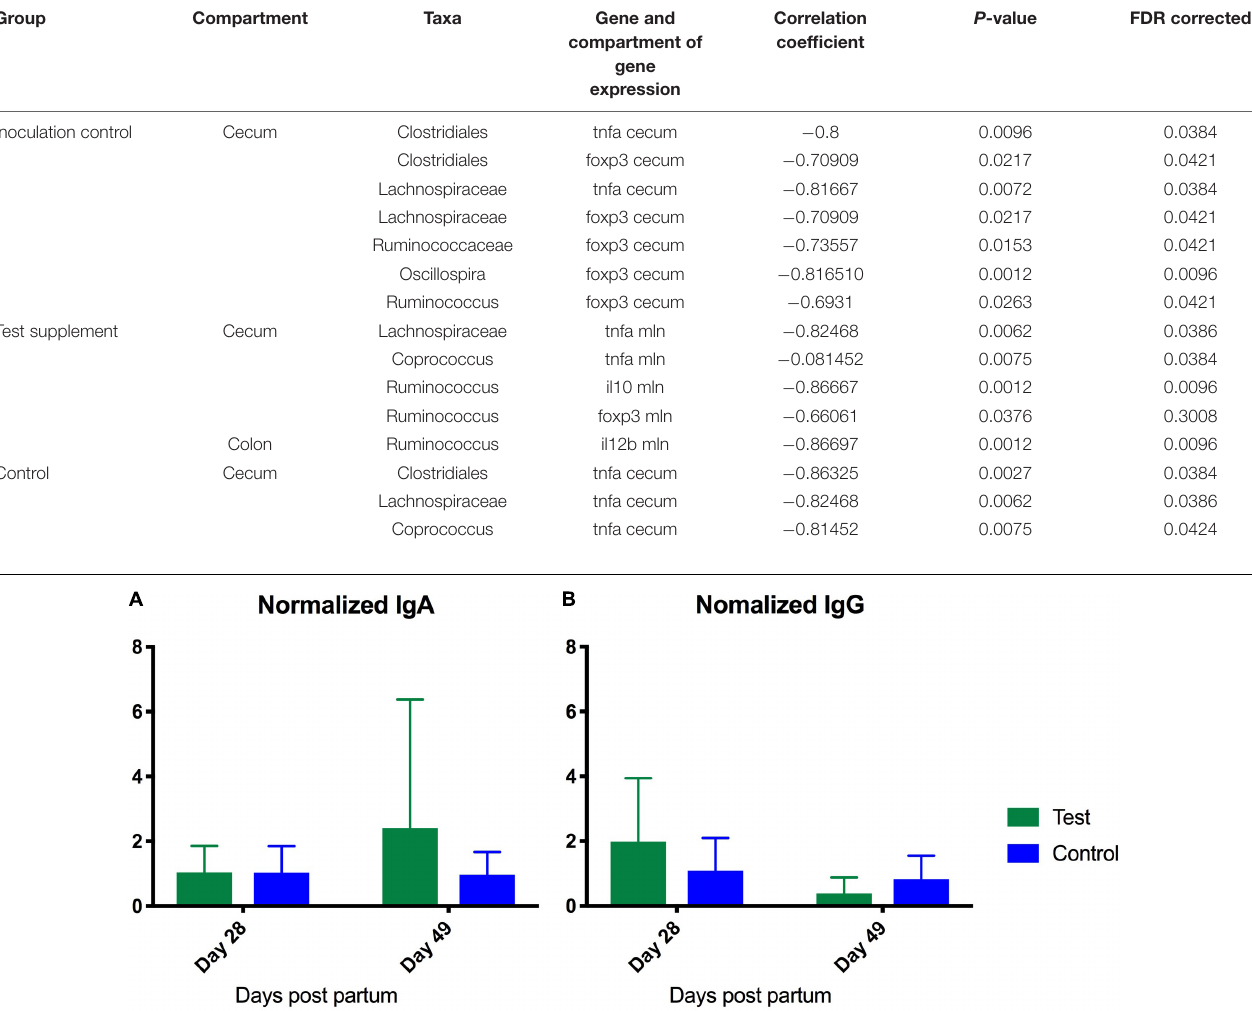
TABLE 2 | Spearman rank correlation analysis between bacterial abundances in the cecum and colon of species previously shown to induce regulatory immunity in horses and gene-expression measured in the cecal mucosa and mesenteric lymph nodes of mice inoculated with fecal material from foals fed a control diet and from mice fed either a test supplement enriched with oligosaccharides or a control diet.